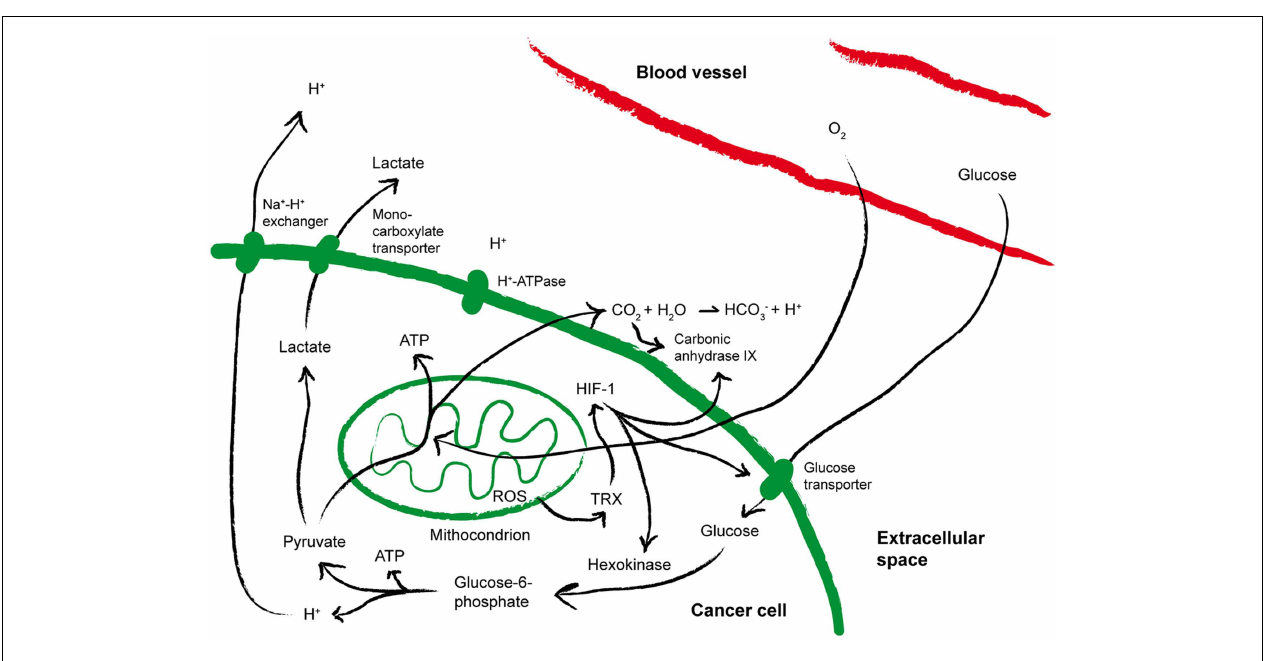
fitness. See the text for more details. ATP, Adenosine-5 (cid:48) -triphosphate; HIF-1, hypoxia inducible factor 1; ROS, reactive oxygen species;TRX,